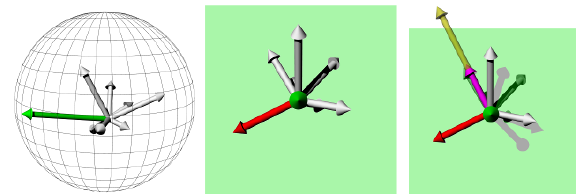
Figure 5. Spherical grid with normal vectors (left). The green vector depicts the most dominant direction in the centre of the figure. The red vector denotes the SDD on the right.